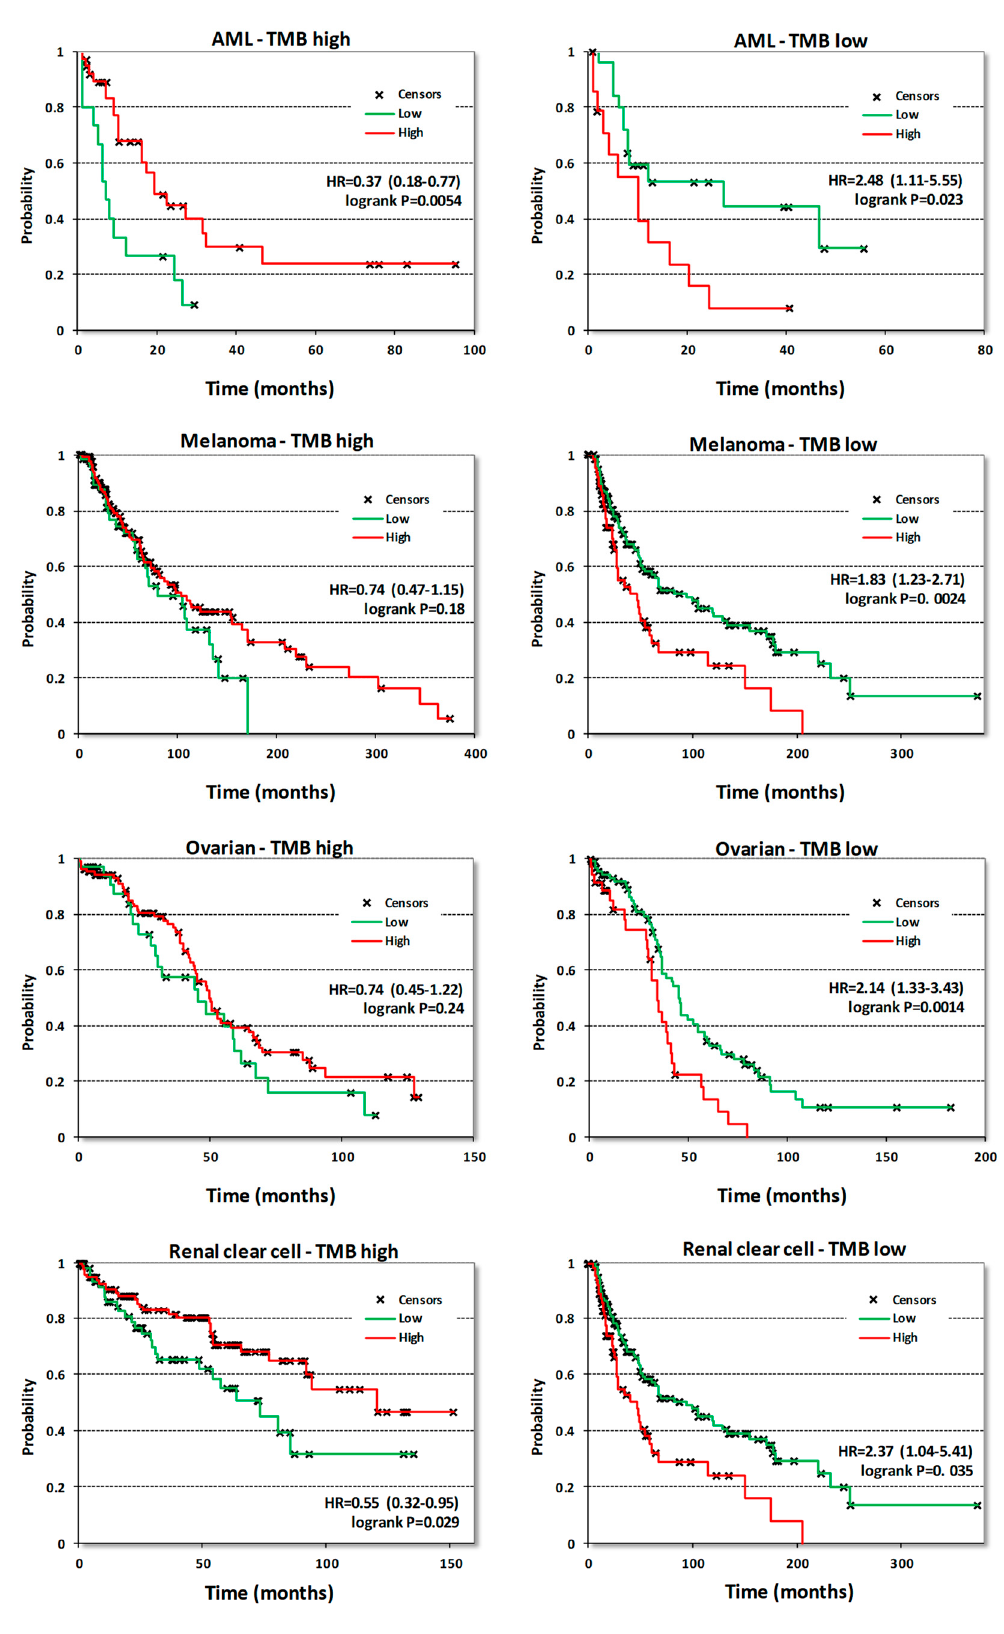
Figure 8. KM plots correlating CDK8 expression with OS in the indicated tumor types stratified into samples with high or low mutation burden. The high / low mutation burden cuto ff for AML was 10 mutated genes per sample, for melanoma 272, for ovarian cancer 79 and for renal clear cell cancer 47.